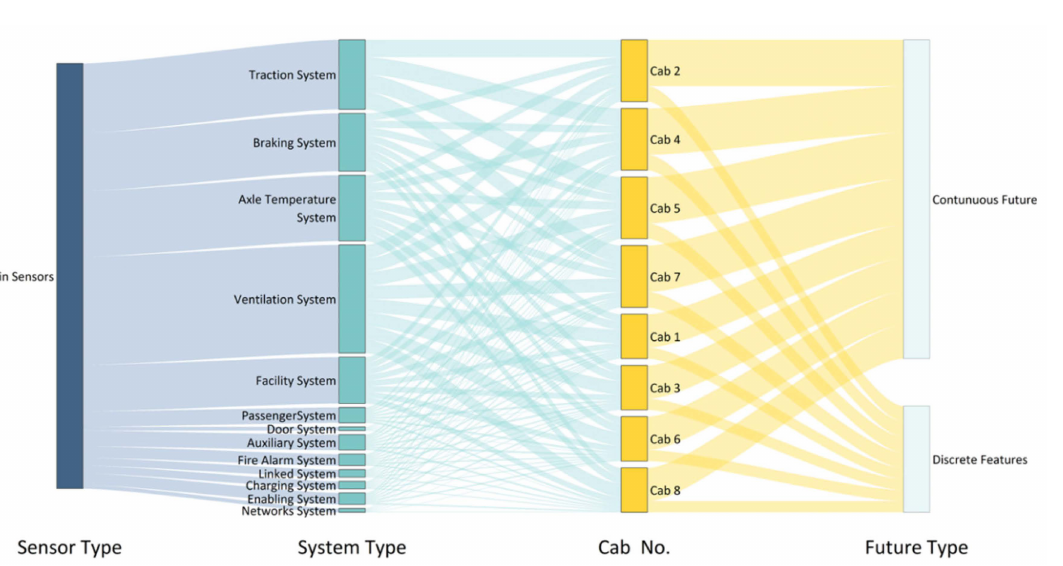
Figure 2. Alluvial diagram of the sensor data